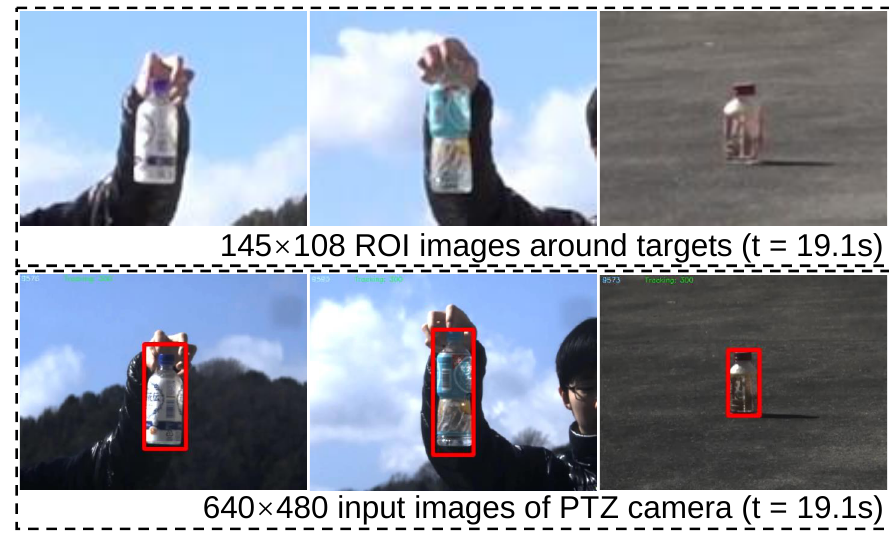
Figure 11. The 145 × 108 ROI images around targets from the digital wide-view camera and 640 × 480 input images from the virtual PTZ cameras (red boxs are the test